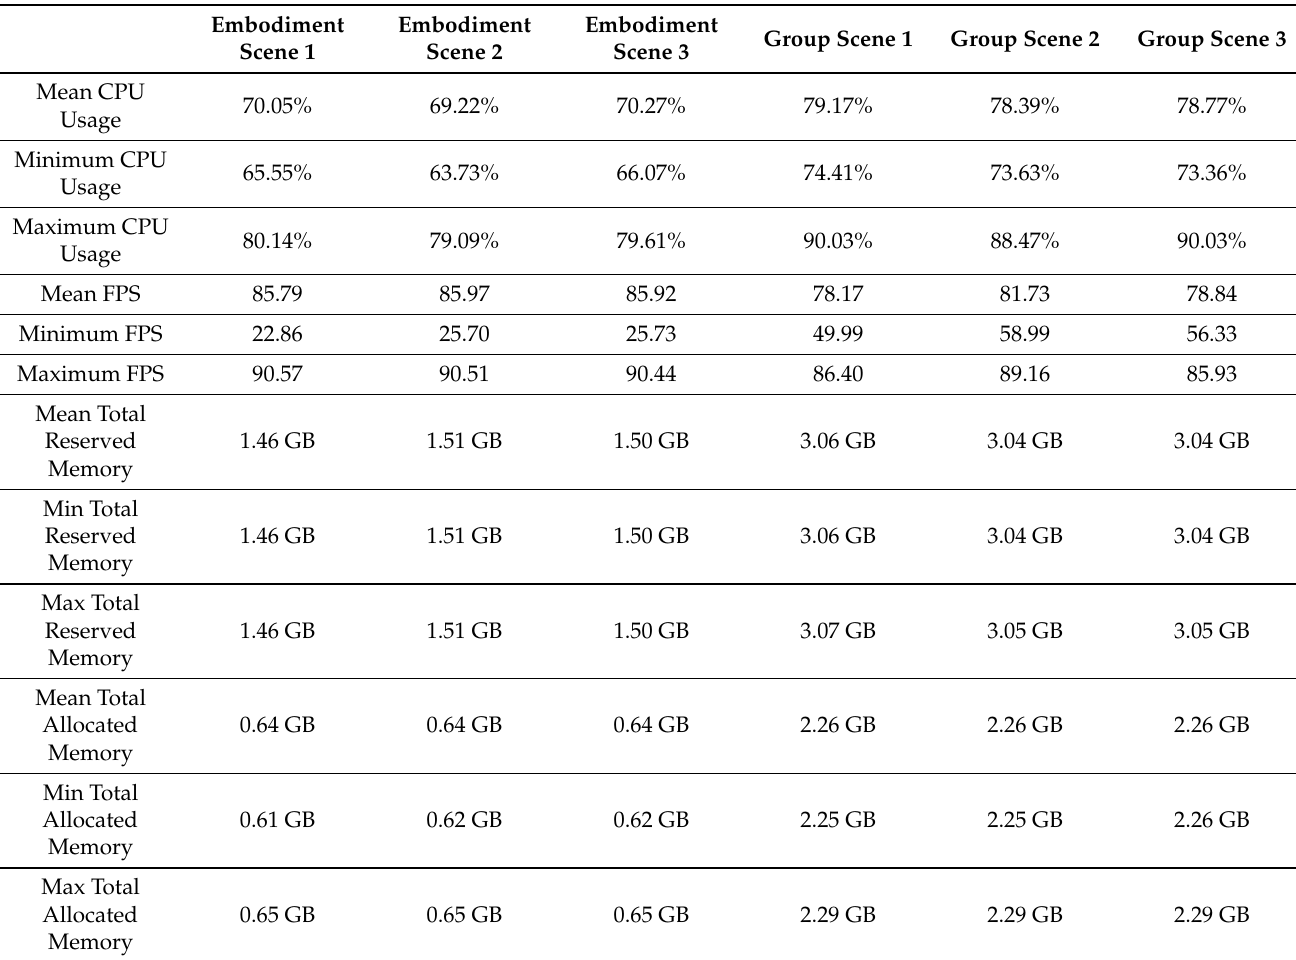
Table A5. Results for Test Condition 3: eye tracker.